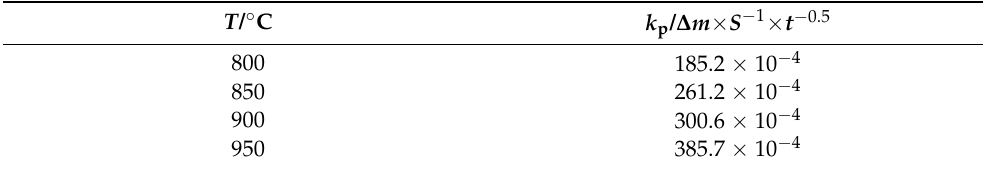
Activation energy E was calculated from Equation (2) and from the slope of the ln[ k p ( T )] versus 1000/ T graph (Figure 10). The activation was finally calculated at 52.105